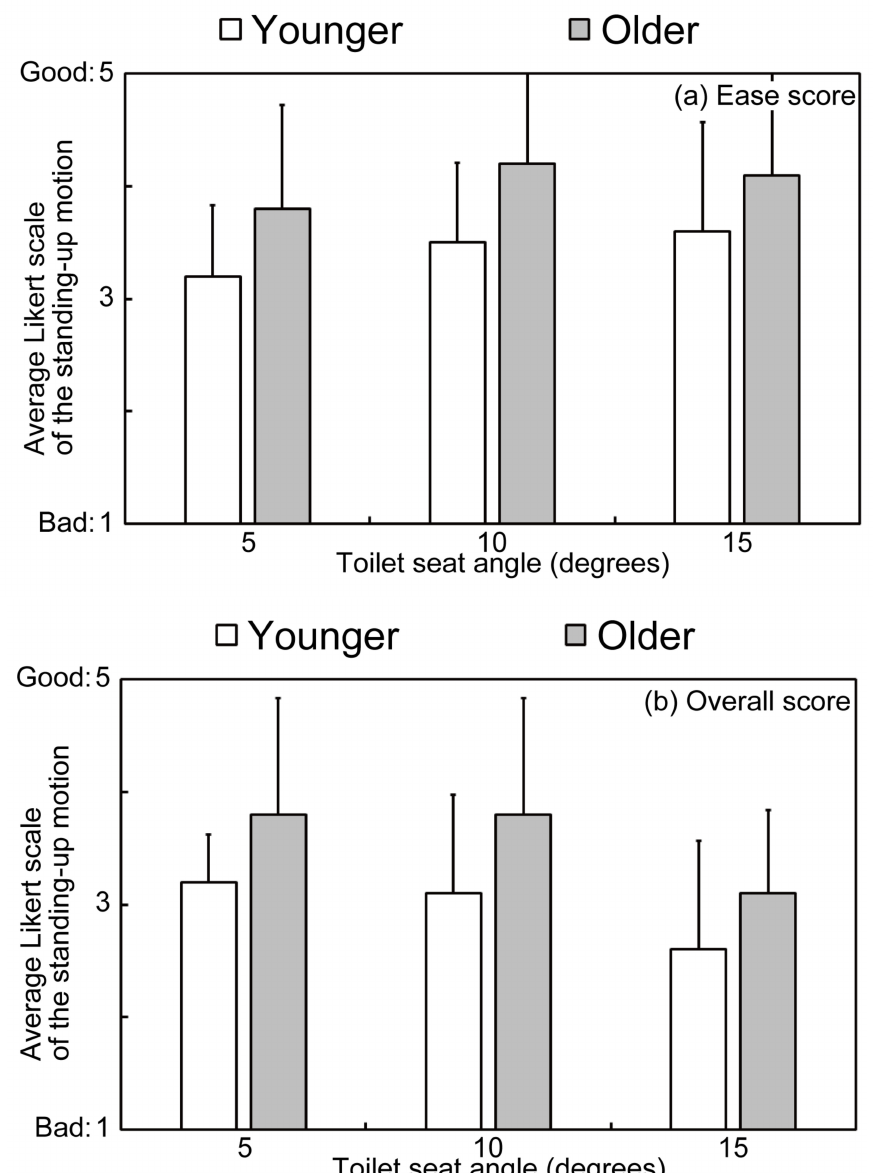
Figure 8. Score based on a 5-point Likert scale for the standing-up motion according to toilet seat angle. ( a ) Ease score and ( b ) overall score according to toilet seat angle. Vertical lines denote the standard error of the mean. In both age groups, the score for the ease of the standing-up motion and overall toilet seat score were not affected by toilet seat